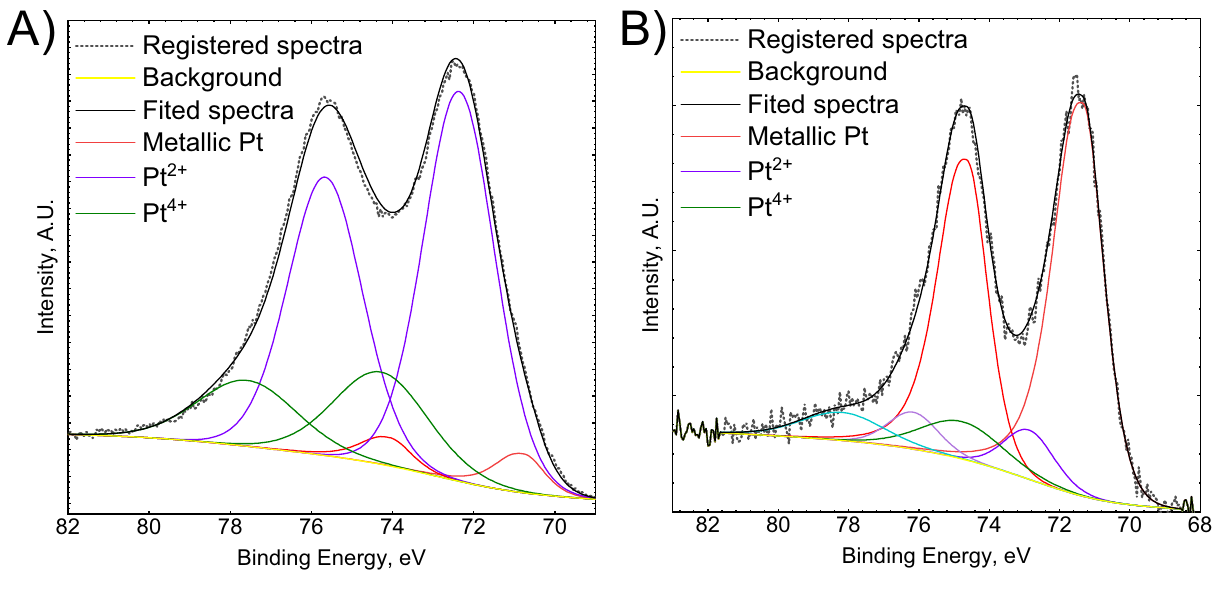
Figure 12. Pt 4f. photoelectron spectra registered for the colloids obtained when [Pt(IV)] = 1 × 10 −4